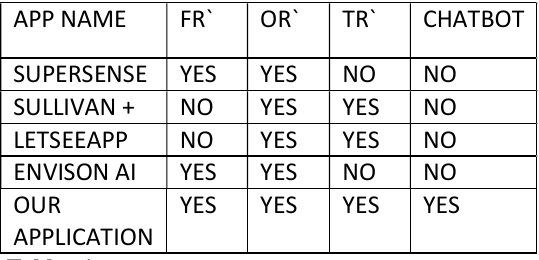
Table 1 Comparison of features provided by each application NOTE- FR`- FACE RECOGNITION; OR`- OBJECT RECOGNITION; TR`-TEXT RECOGNITION NOTE- As the algorithms used in the other applications are unknown to us .We have contacted their developers but haven’t got any responses yet. So, we have done the comparison based on features